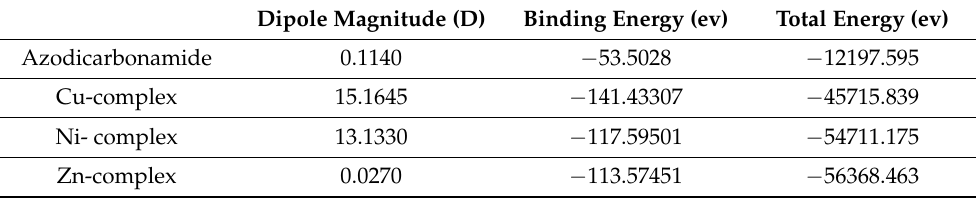
Table 11. Various theoretical molecular parameters of azodicarbonamide and its complexes. Dipole Magnitude